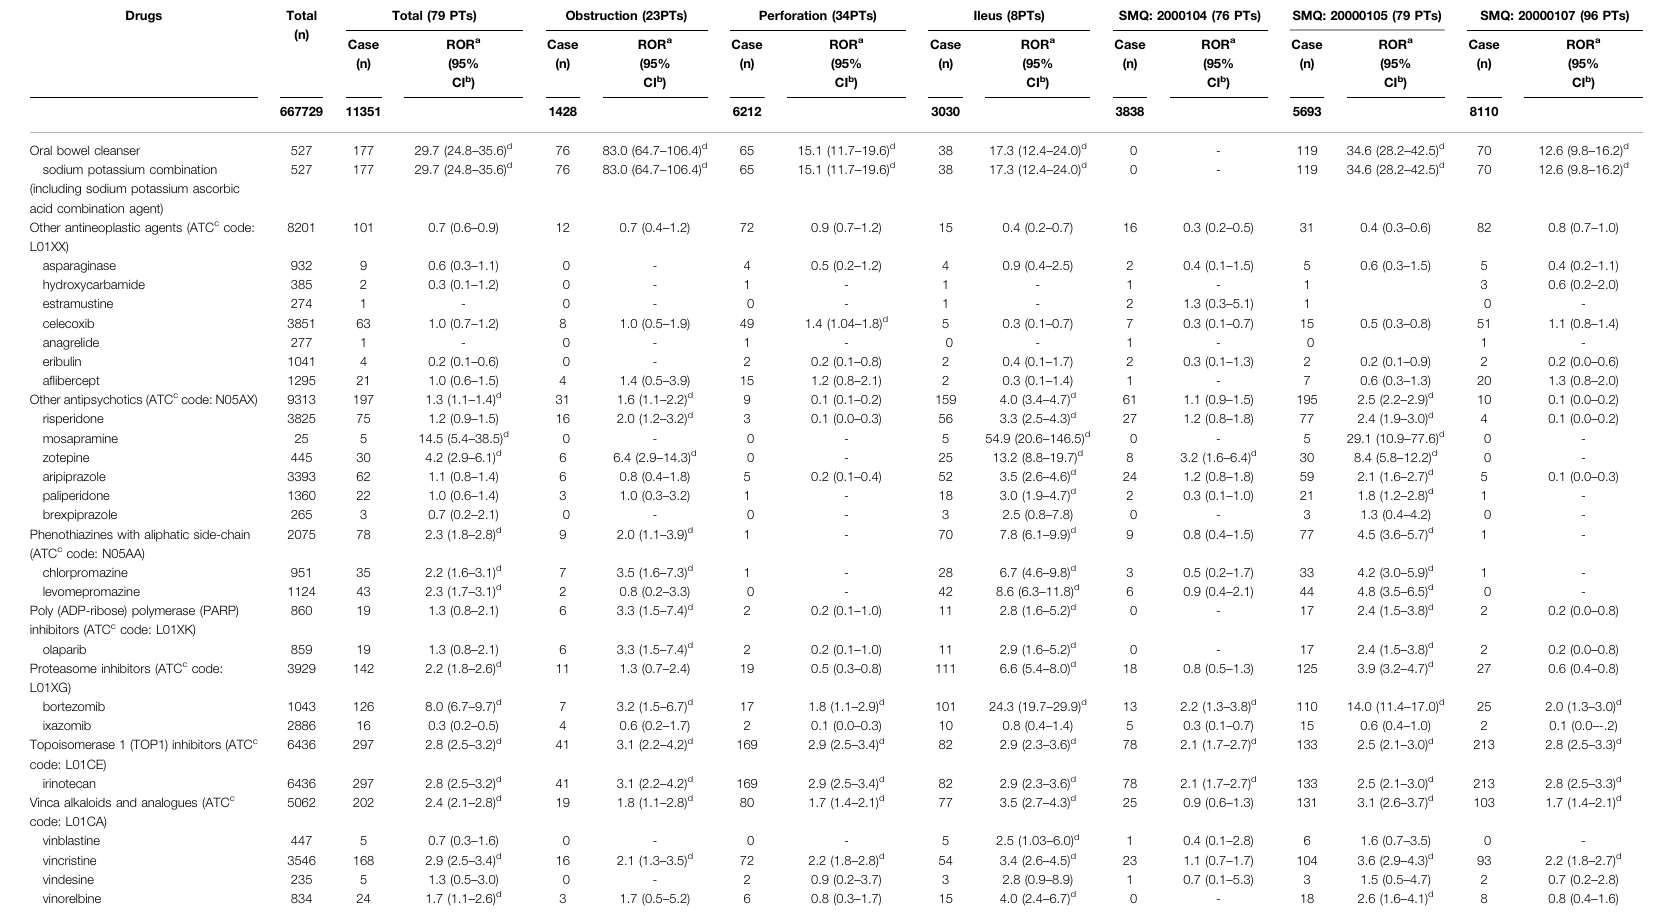
a ROR: Reporting odds ratio b CI: Con fi dence interval c ATC: the Anatomical Therapeutic Chemical (ATC) classi fi cation system described by the World Health Organization Collaborating Centre for Drug Statistics Methodology (www.whocc.no/atc_ddd_index) d Lower limit of 95% CI > 1 Number of cases <